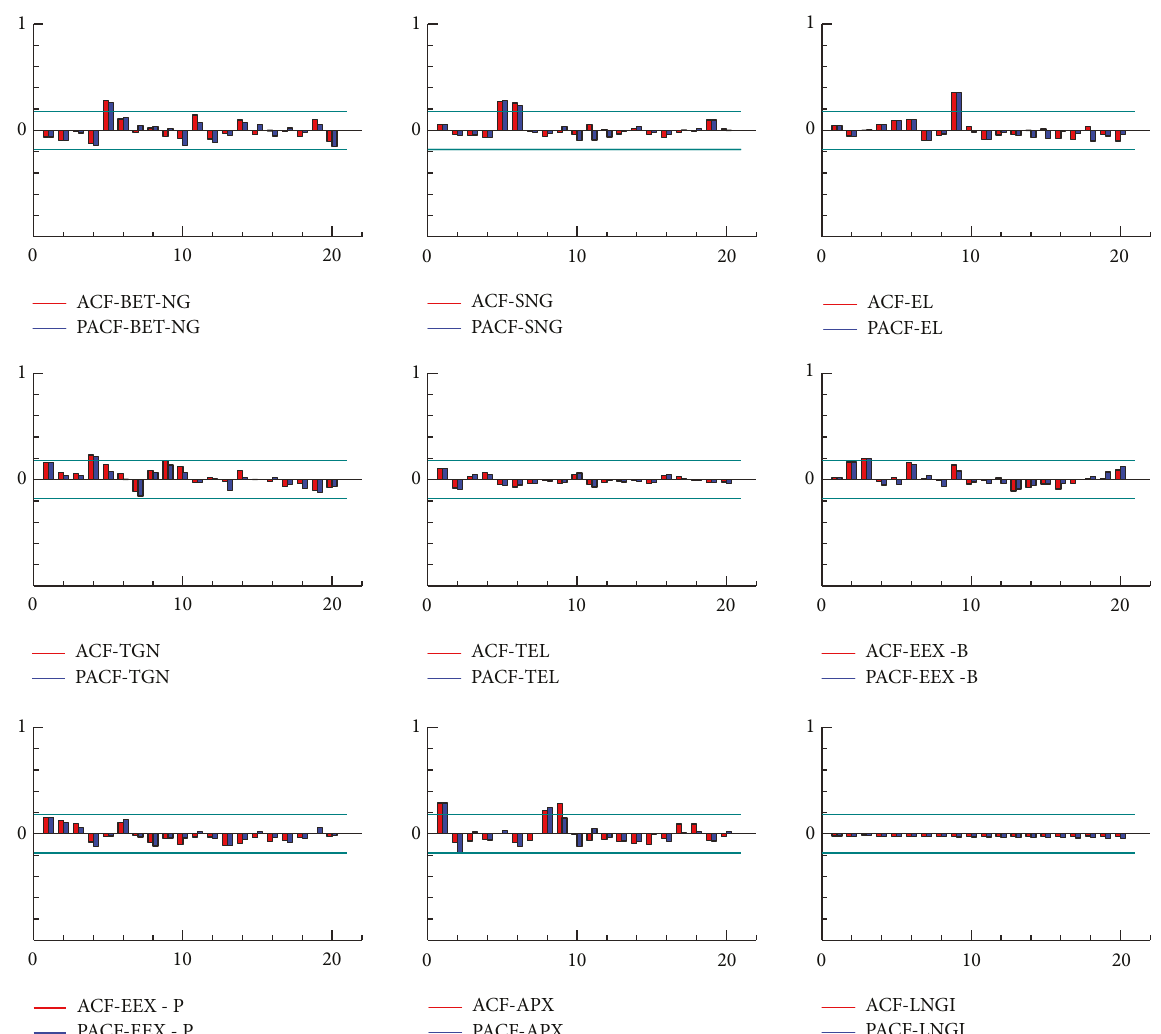
Figure 6: Plots of autocorrelation function (ACF) and partial autocorrelation function (PACF) for squared returns. Source: author’s own work. Notes: the lag length was set to 20. Variables’ descriptions are provided in Table